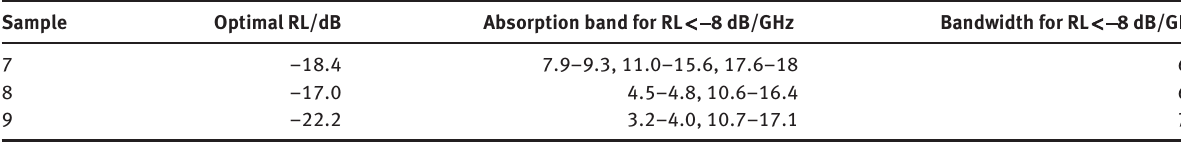
Table 5: Detailed data of double-layer cement composites with Ni-Zn ferrite in different layers.